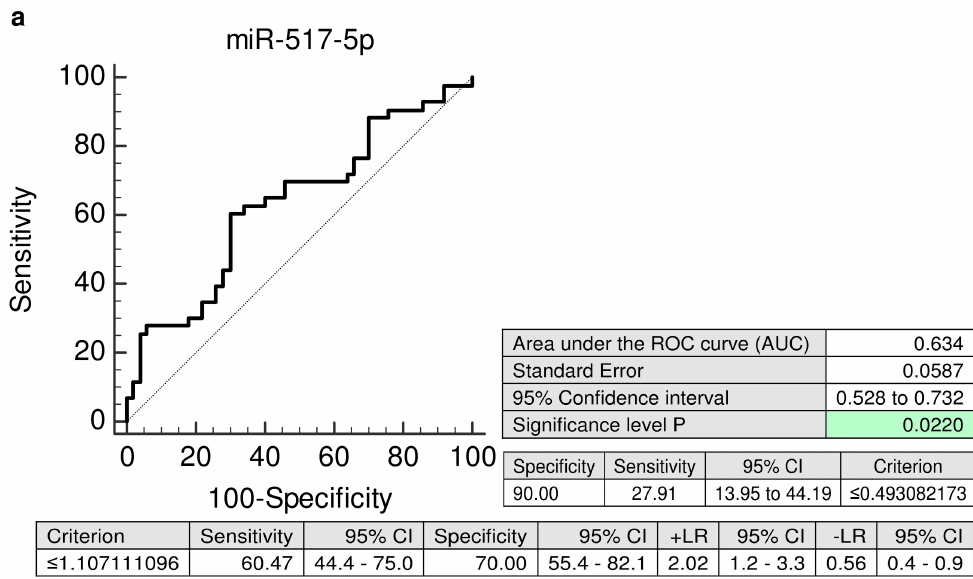
Figure 3. ROC curves—the best combination of C19MC microRNA biomarkers—evaluation of the potential of the first trimester C19MC microRNA screening in plasma exosomes to predict later onset of GH. The combination of miR-520a-5p and miR-525-5p showed the best predictive performance for the prediction of the later occurrence of GH (66.07% sensitivity at 10.0% FPR). GH: gestational hypertension.